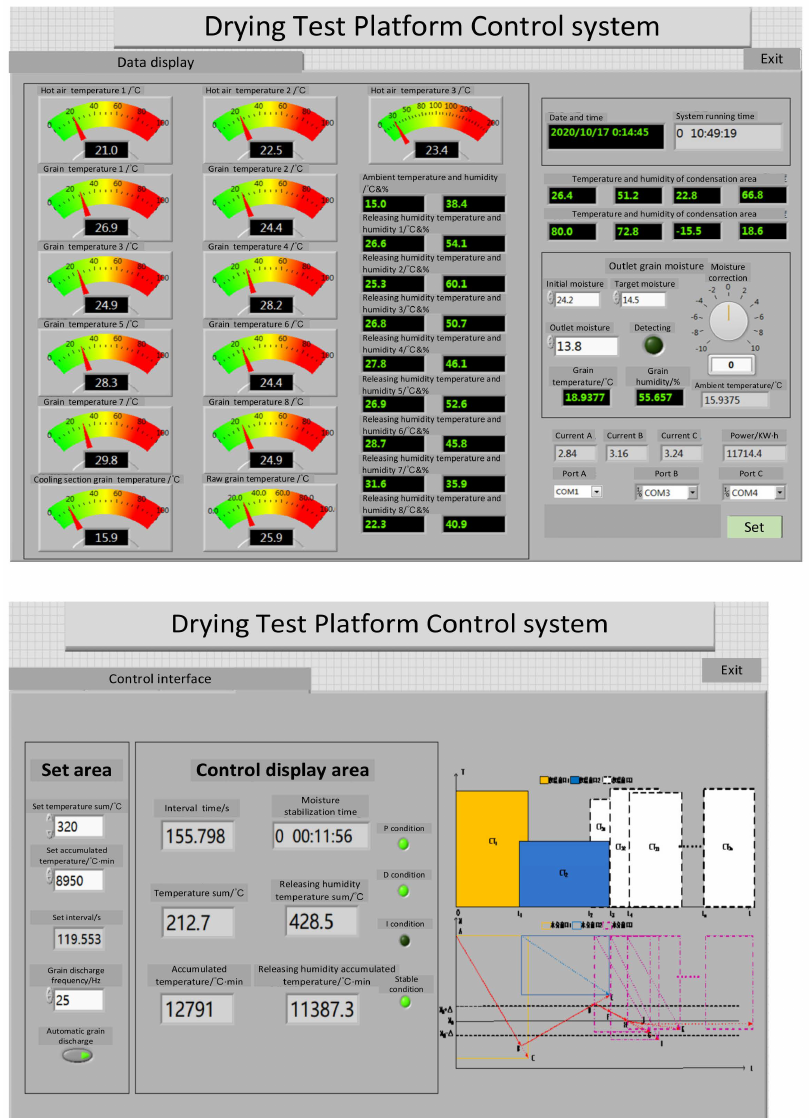
Figure 5. System software interface.